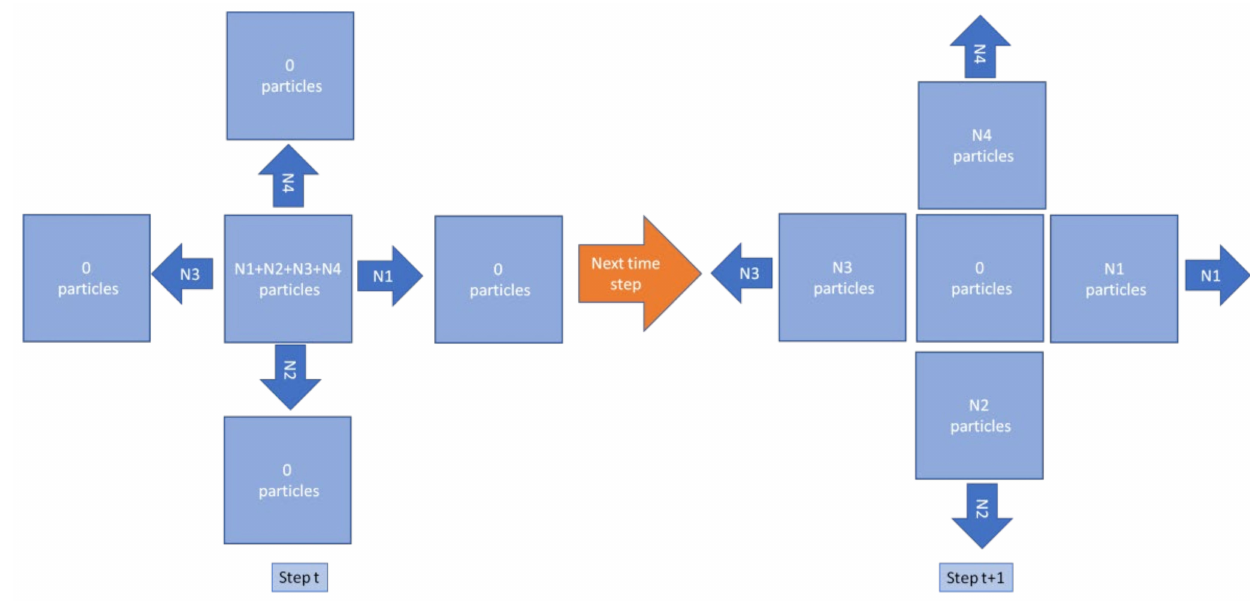
Figure 3. Fluid particles’ motion to neighboring cells in accordance with their